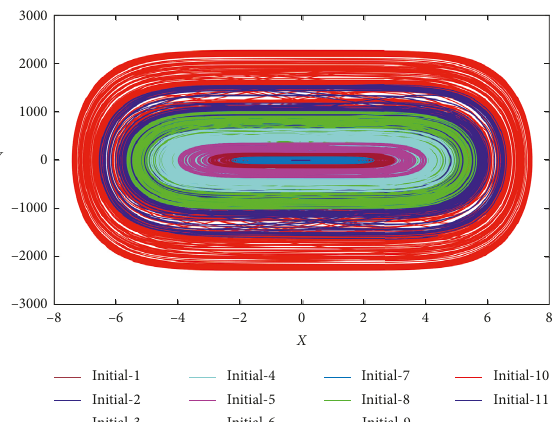
Figure 8: Multiple coexisting attractors for β � 7 with different initial conditions [ P, 0 , 0 . 1 , 0 ] where P takes the values of [ 0 . 5 , 1 , 2 , 3 , 4 , 5 , 6 , 7 , 8 , 9 , 10 ] for initial-1 to initial-11,